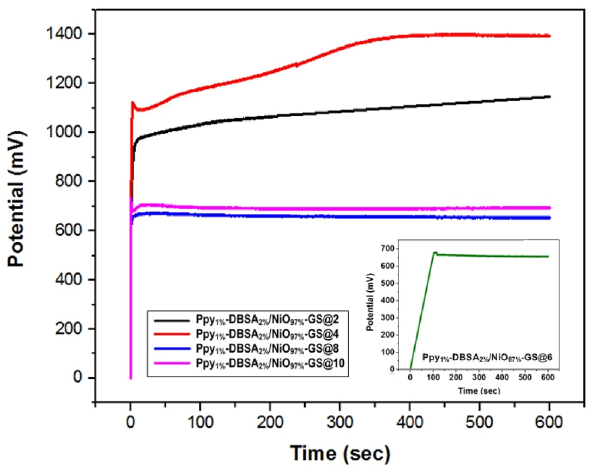
Figure 1. Potential versus time curves of the chronopotentiometry processes of Ppy 1% -DBSA 2% /NiO 97% -GS at different current densities from 2 to 10 mA cm −2 .